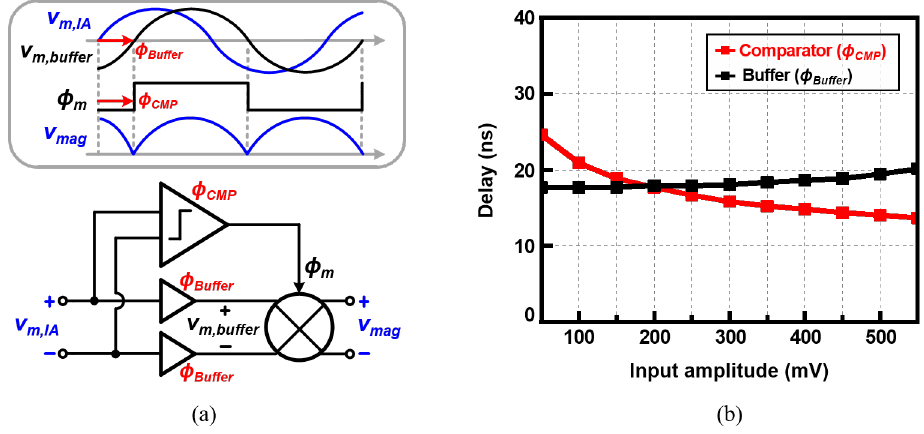
Figure 9. ( a ) Block diagram and operation waveforms of the mixing part of the proposed work, and ( b ) simulated input–output delays of the comparator and the buffer over the input amplitude when the input frequency is set to 1 MHz.